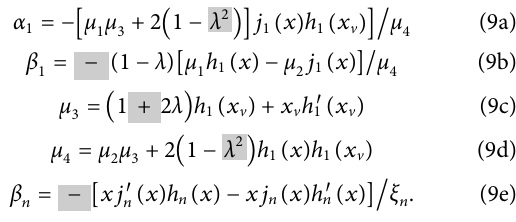
Frontiers in Physics |